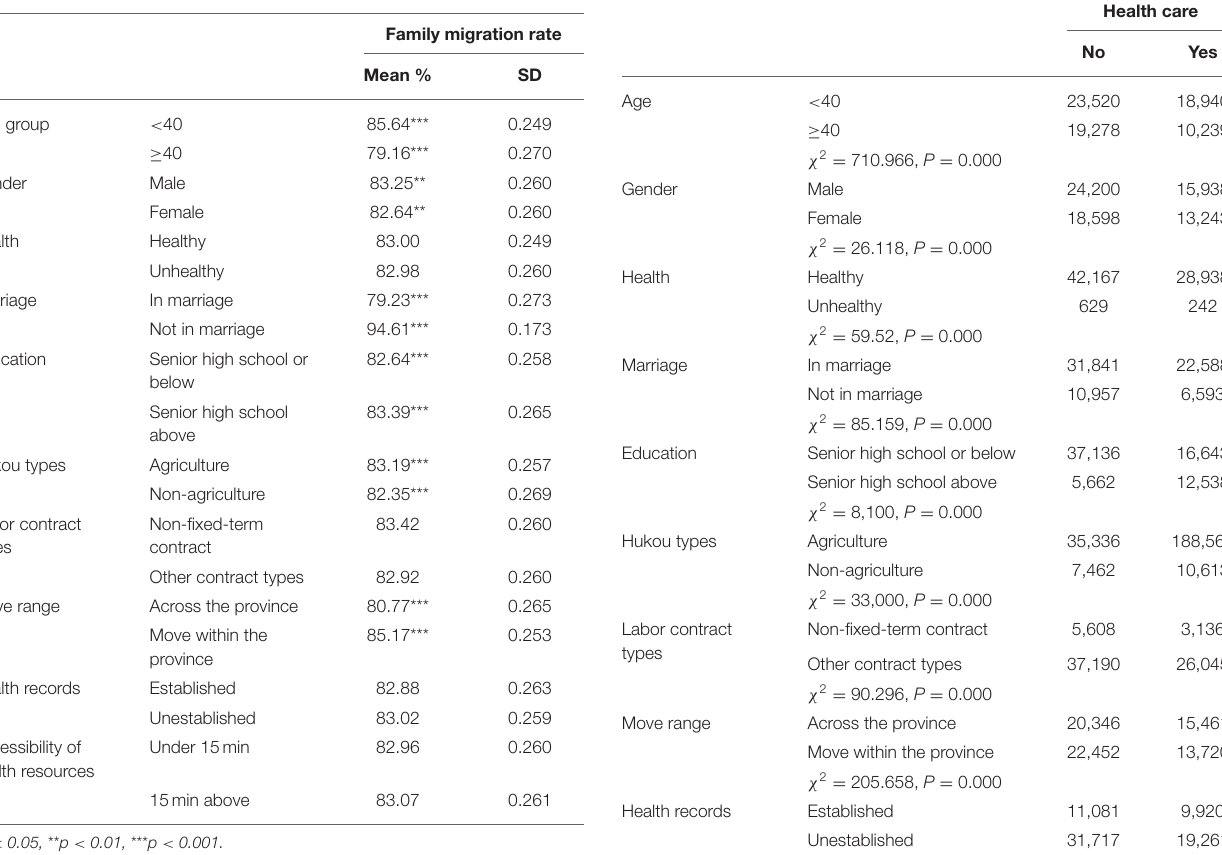
TABLE 3 | Heterogeneity of Family migration rate by migrants’ characteristics ( N = 71,979).